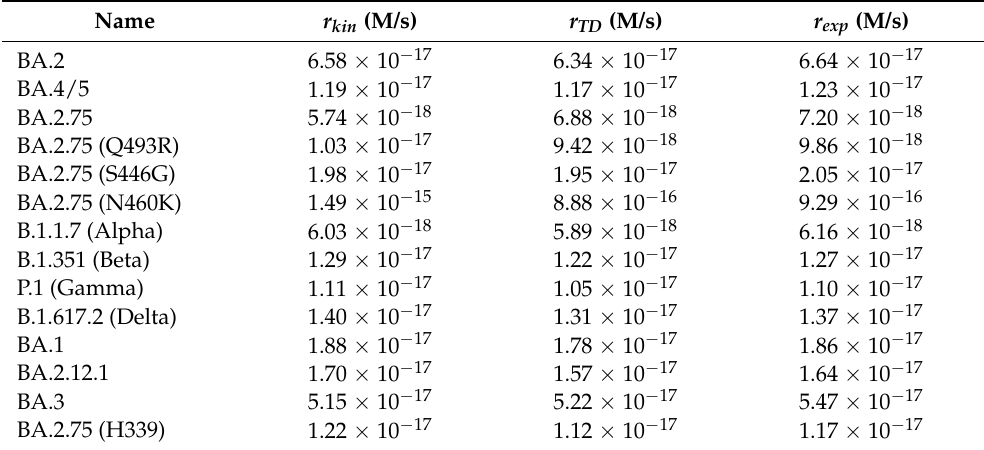
Table 2. The binding rates of SARS-CoV-2 variants. The table shows r kin , r TD , and r exp : binding rates calculated using the kinetic, thermodynamic, and exponential methods, respectively. The values were calculated at Q = 0.91 K B